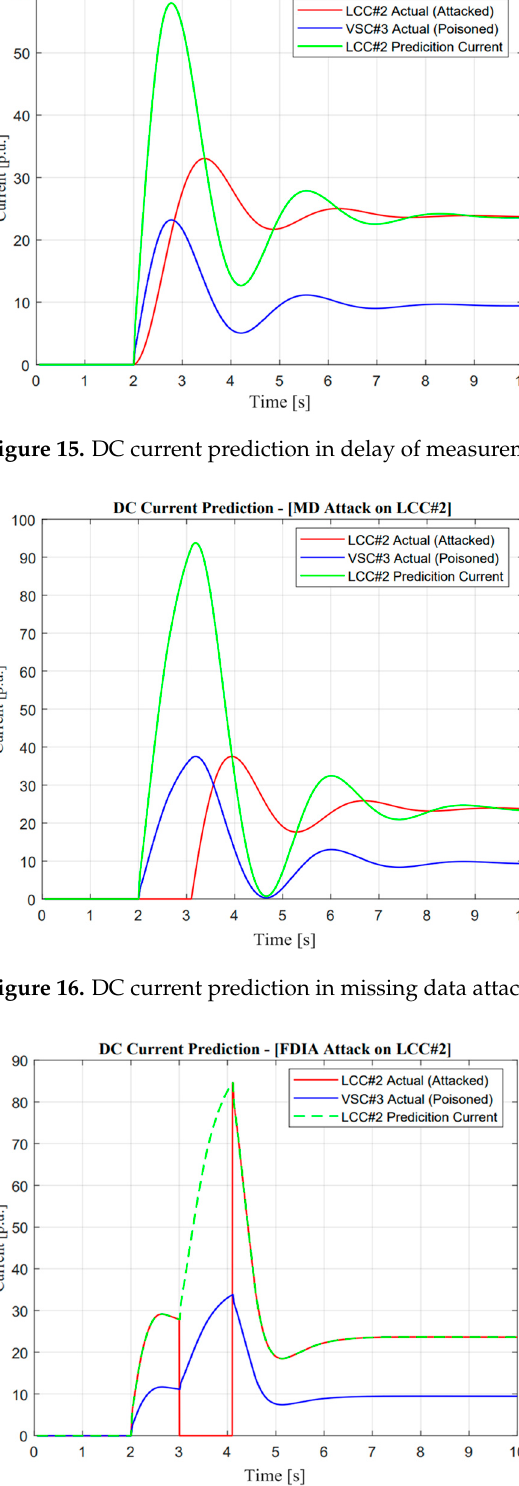
Figure 14. DC current prediction in normal operation.